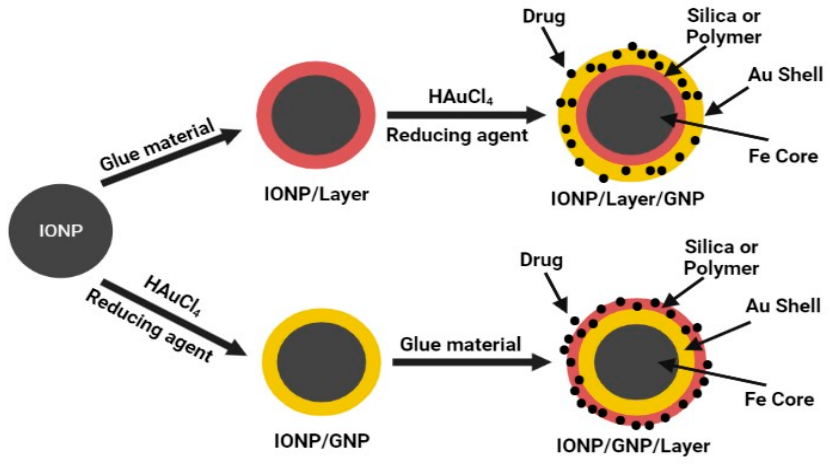
Figure 1. Schemes of synthesizing magnetic gold nanoparticles with intermediate